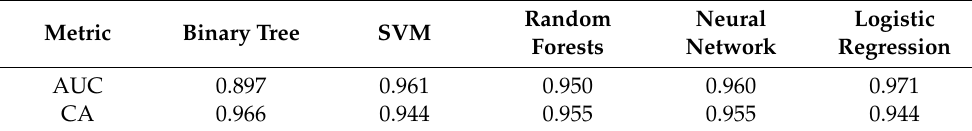
Table 11. Models accuracy metrics for add_to_cart_direct as target parameter.